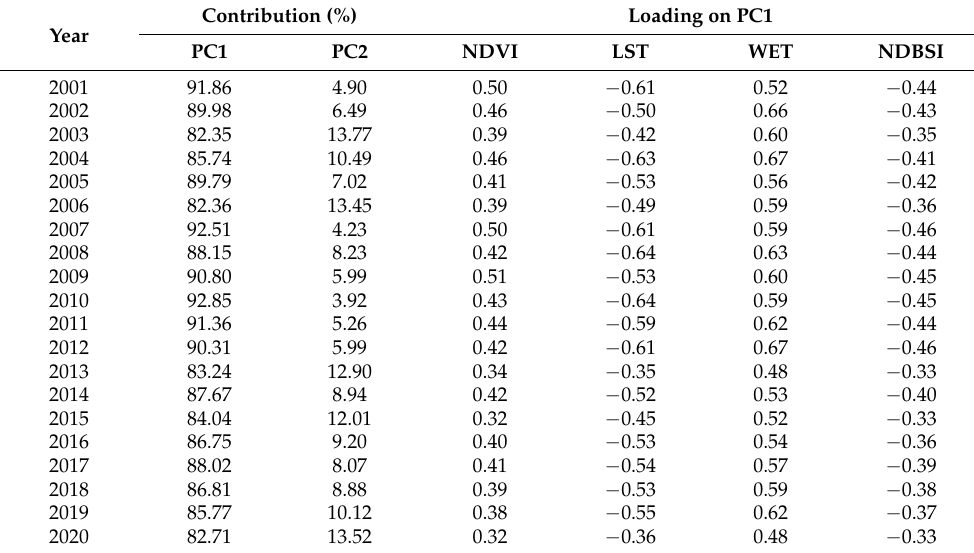
Table 4. Results of principal component analysis.